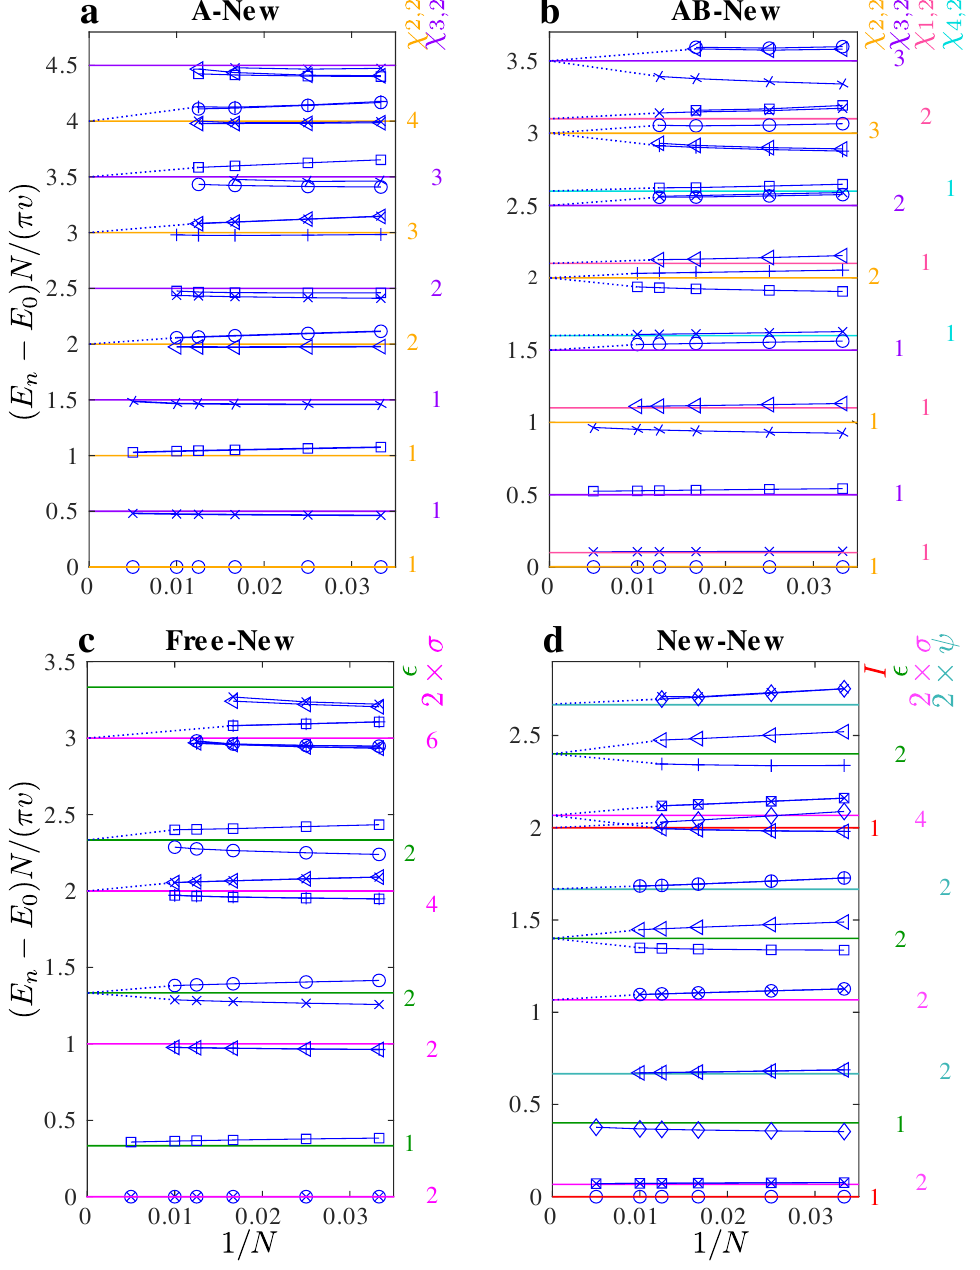
Figure 2: Conformal towers of states of the critical three-state Potts model with one edge polarized along the transverse field direction (following Ref. [ 24 ] we use the no- tation ’new’) and the second edge is (a) fixed to one of the three single-particle states; (b) mixed between the two single-particle states; (c) free; (d) also polarized along (cid:112) the transverse field. The velocity is fixed to the exact value v = 3 / 2. Blue symbols correspond to our DMRG data (different symbols are chosen to clarify multiplicities), lines of different colors correspond to different primary fields in the tower and listed on the right. The numbers under each character show the expected multiplicities of the levels and always match our numerical data. Blue dotted lines are guide to the eyes indicating where the energy levels are expected to end in the thermodynamic limit and for infinite DMRG bond dimension D